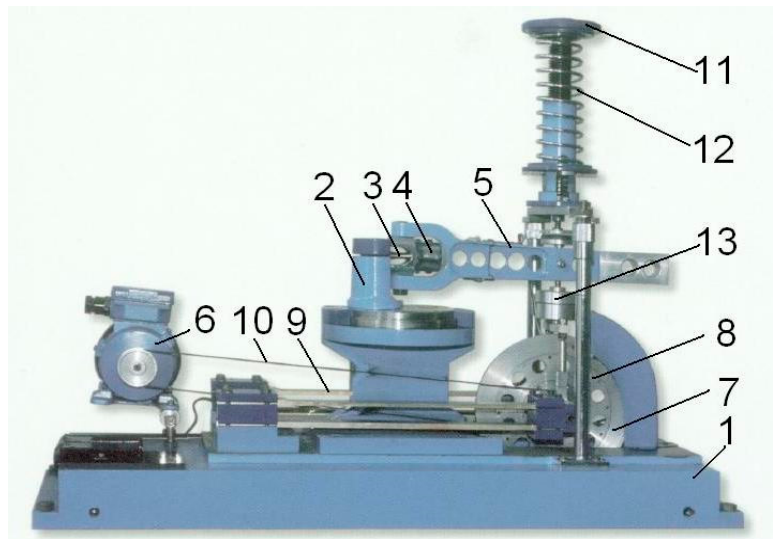
Figure 4. Fatigue testing machine MZGS-100: 1—bed, 2—rotational head with a holder, 3—specimen, 4—holder, 5—lever (effective length = 0.2 m), 6—motor, 7—rotating disk, 8—unbalanced mass, 9—flat springs, 10—driving belt, 11—spring actuator, 12—spring, 13—hydraulic connector [36].